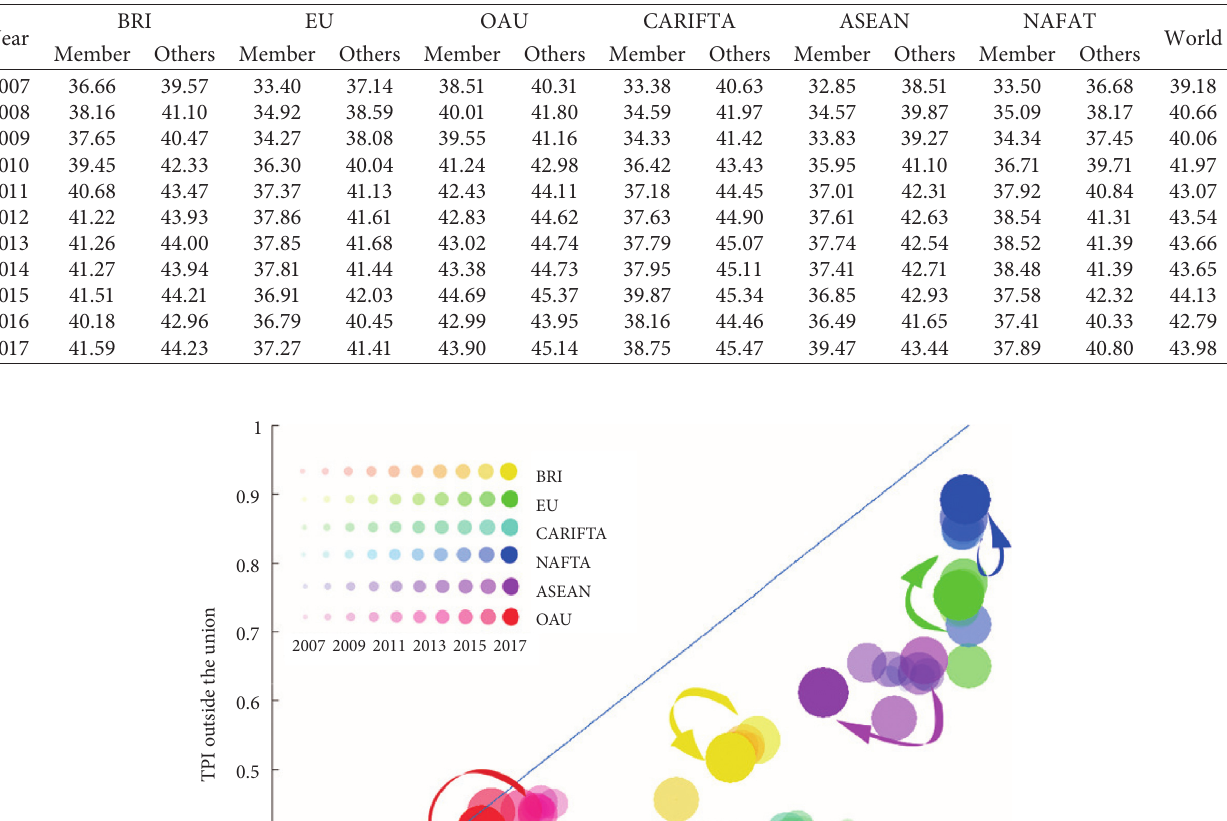
Table 2: Average trade resistance within and outside trade unions.